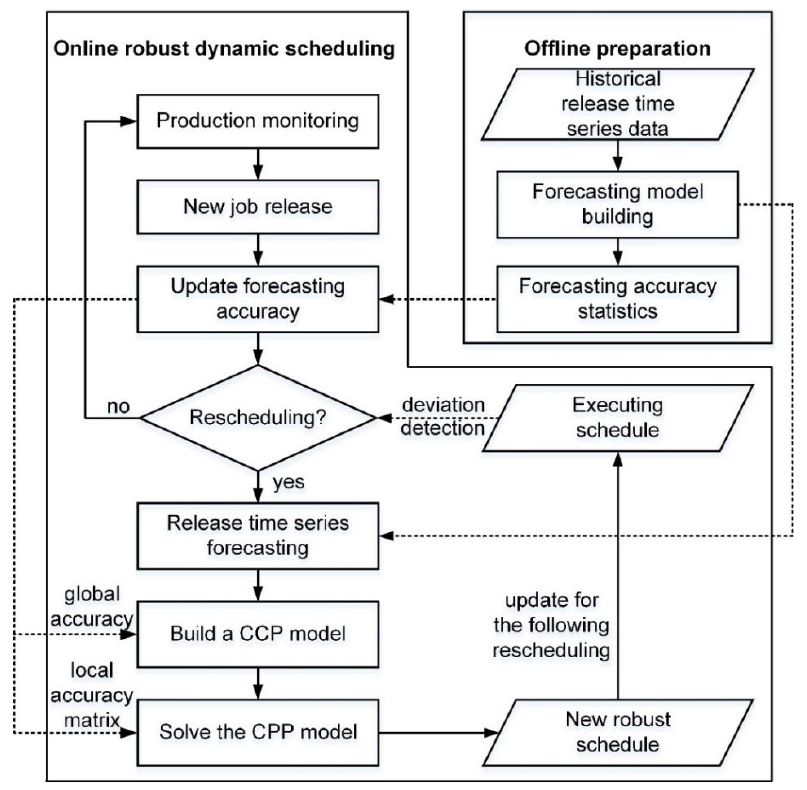
Figure 9. A novel robust scheduling framework based on release time series forecasting [88].